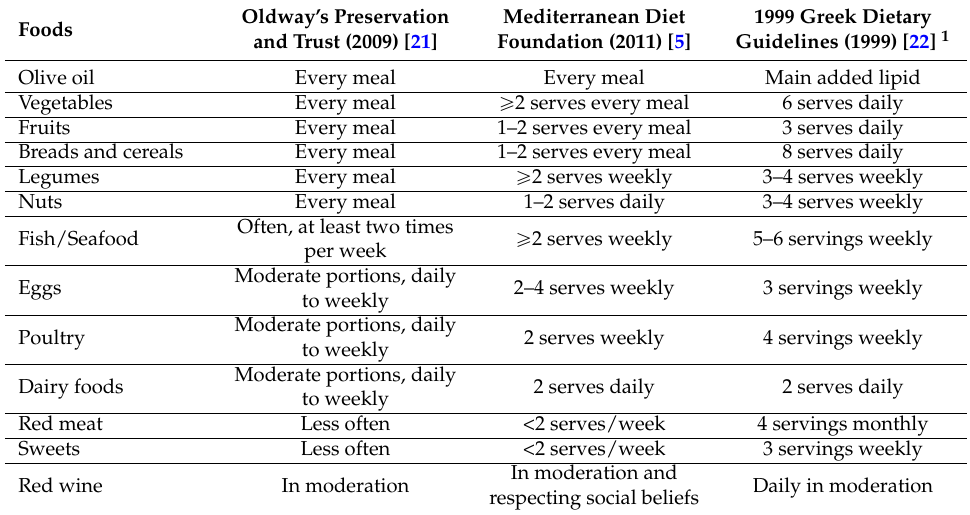
Table 1. Comparison of dietary recommendations for three Mediterranean diet